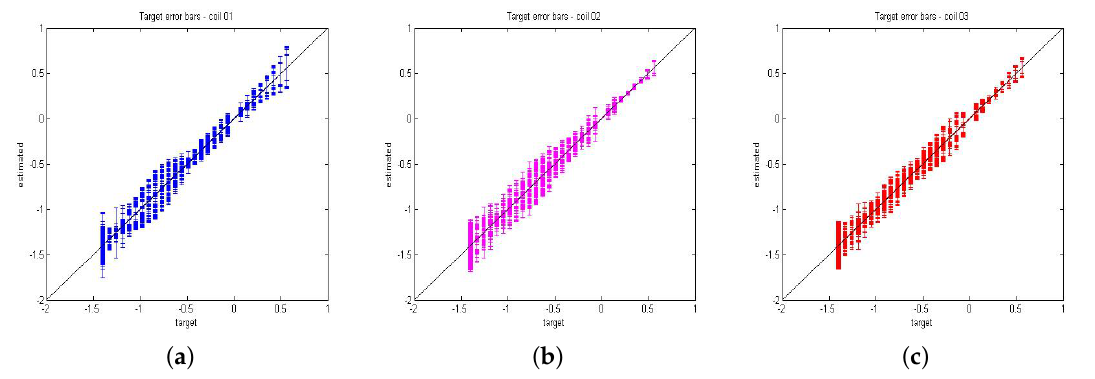
Figure 8. Scatterplots of the targets values versus the predicted ones for the test data: ( a ) current I 1 ; ( b ) current I 2 ; and ( c ) current I 3